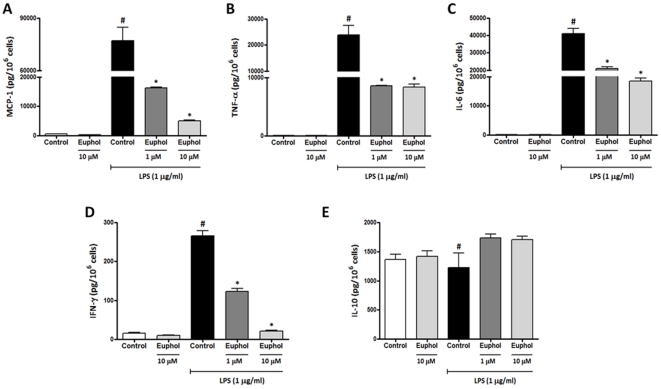
Euphol reduces pro-inflammatory cytokines and chemokines production in macrophages stimulates with lipopolysaccharide (LPS).Macrophage from bone marrow of naïve mice were stimulated with LPS (1 µg/ml) in the presence or absence of euphol (1 and 10 µM) for 24 hours, and the culture supernatants were analyzed for cytokine levels using cytokine bead array kit (CBA). Euphol incubation in dose-related manner reduced production of MCP-1 (A), TNF-α (B), IL-6 (C), IFN-γ (D), but increase the IL-10 levels (E). Data are reported as means ± SEM (n = 4) and is representative of two independent experiments. #P<0.05 vs. control without LPS treatment (vehicle solution); *P<0.05 vs. LPS-treated group. Vehicle solution corresponds to 5% Tween 80 in medium.